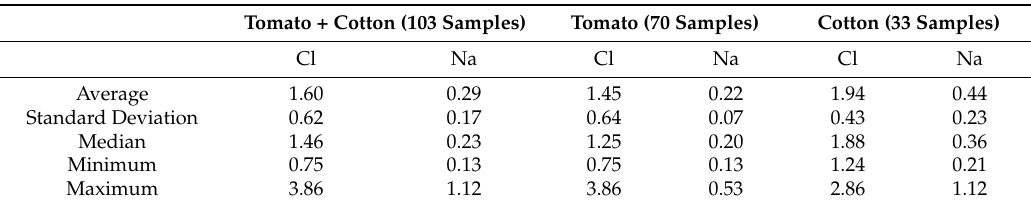
Table 1. Average, standard deviation, median, minimum and maximum values of Cl and Na concentrations (wt%) in tomato and cotton.